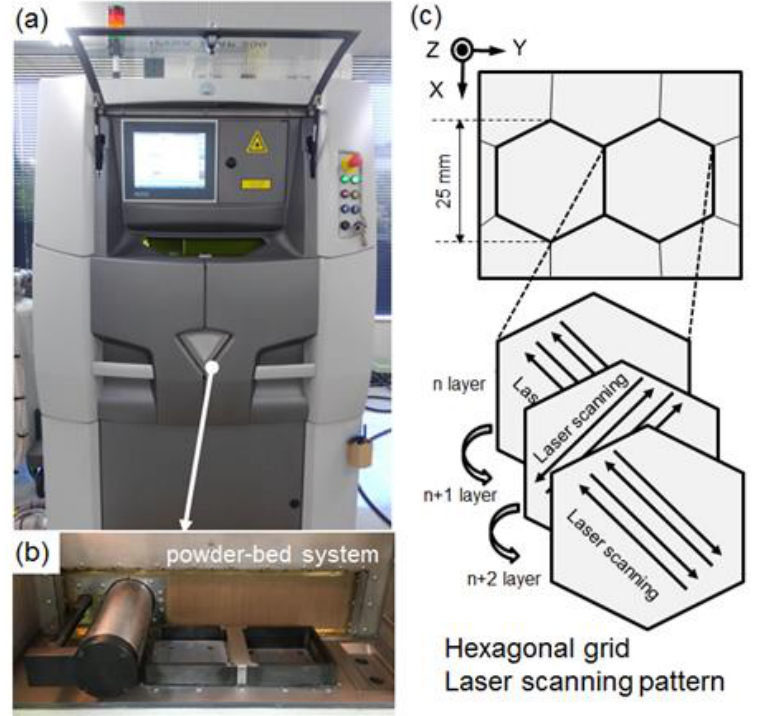
Figure 2. ( a ) Appearance of the used selective laser melting (SLM) machine (3Dsystems ProX 200) and ( b ) inside a chamber for powder-bed system, ( c ) schematic of the laser-scanning tracks on each